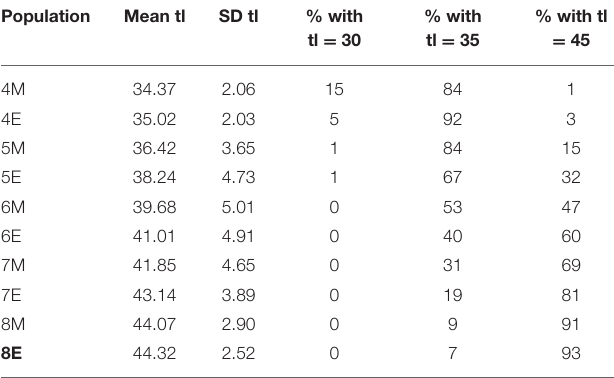
(compared with Table 2 ). For the accuracy of the measurement of the CATs, the root mean square error (RMSE) is considered. With θ j and ˆ θ j , the true and the estimated ability (3) of